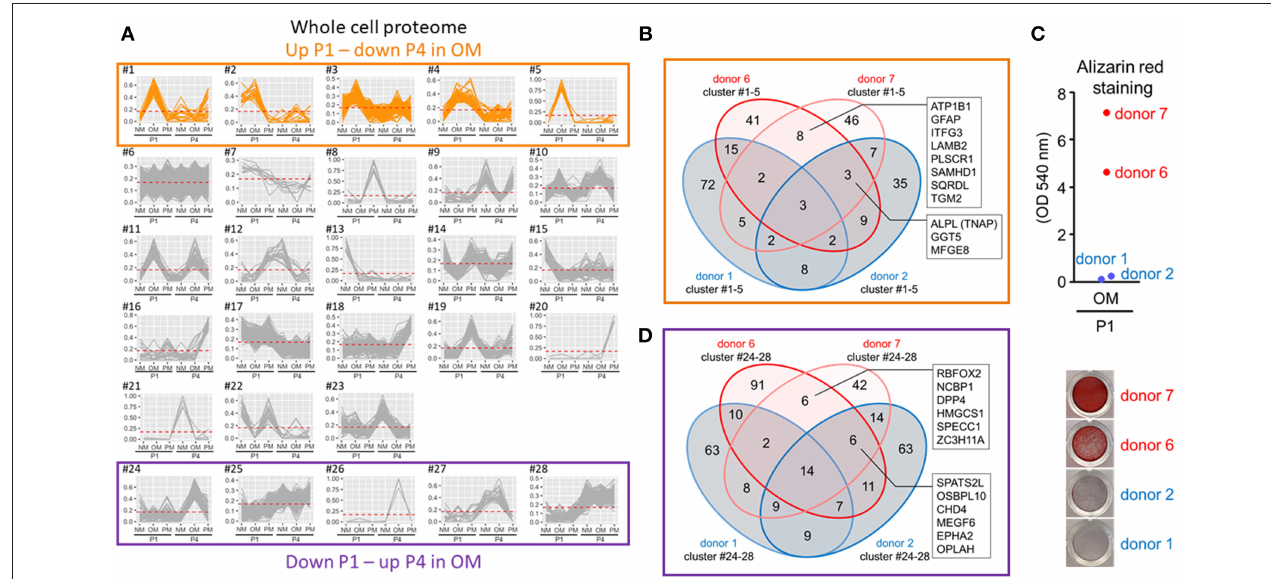
FIGURE 5 | Valvular interstitial cell whole cell proteomics identified TNAP as a regulator of donor- and passage-dependent calcification in OM. (A) XINA clustering analysis of protein abundances in NM, OM, and PM. Clusters with increased protein abundance at passage one (P1) and decreased abundance at passage four (P4) in OM indicated in orange (clusters #1–5). Clusters with decreased protein abundance at P1 and increased abundance at P4 in OM indicated by purple box (clusters #24–28); n = 4 donors. (B) Venn diagram showing total number of proteins detected for the four donors analyzed (donors 1, 2, 6, 7) and found in the five identified clusters in which abundance was increased at P1 and decreased at P4 in OM. Calcification-prone donors (calcified at P1 in OM; donors 6 and 7) indicated by red color, and calcification-resistant donors (did not calcify at P1 in OM; donors 1 and 2) indicated by blue color. Proteins detected in the five clusters of the two calcification-prone but not in the calcification-resistant donors indicated: sodium/potassium-transporting ATPase subunit beta-1 (ATP1B1), glial fibrillary acidic protein (GFAP), family with sequence similarity 234 member A (ITFG3), laminin subunit beta 2 (LAMB2), phospholipid scramblase 1 (PLSCR1), SAM, and HD domain containing deoxynucleoside triphosphate triphosphohydrolase 1 (SAMHD1), sulfide:quinone oxidoreductase (SQRDL), and transglutaminase 2 (TGM2). Proteins detected in the five clusters in the two calcifying donors and one of the two non-calcifying donors indicated: tissue non-specific alkaline phosphatase activity (TNAP), gamma-glutamyltransferase 5 (GGT5), milk fat globule-EGF 8 (MFGE8). (C) Alizarin red staining at P1 for the four donors used in proteomics analysis (data also included, in part, in Figure 1B ). (D) Venn diagram showing total number of proteins detected for the four donors analyzed (donors 1, 2, 6, 7) and found in the five identified clusters in which abundance was decreased at P1 and increased at P4 in